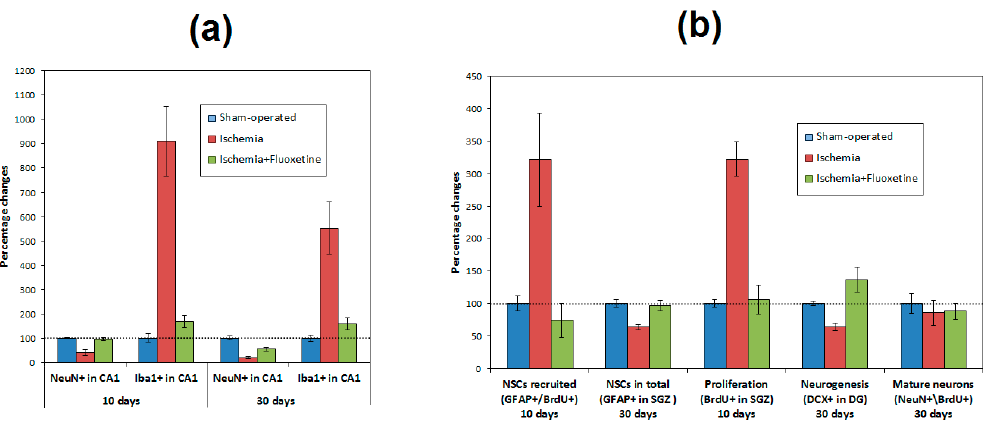
Figure 6. Summary of fluoxetine effects on neuronal loss, inflammation, and neurogenesis in the DG after GCI. ( a ) Mean percentage changes in the number of NeuN+ and Iba1+ cells in the CA1 field at days 11 and 31 after GCI; ( b ) Mean percentage changes in the number of recruited NSCs, and proliferation at day 11 after surgery, and in total number of NSCs, neurogenesis, and mature neurons at day 31 after surgery.